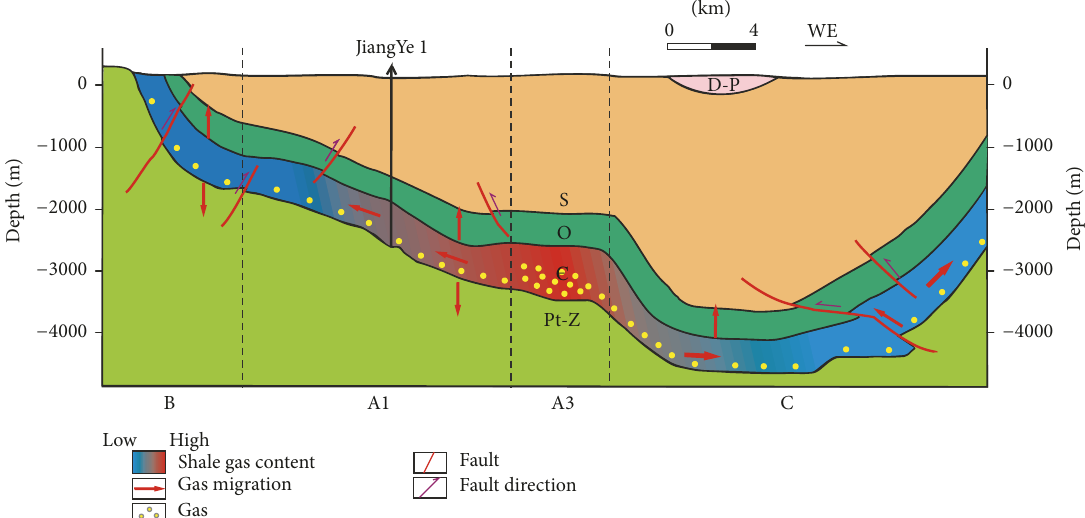
Figure 11: Evaluation units and shale gas accumulation diagram of seismic line EW303.4, Xiuwu Basin. See Figure 10 for the seismic line location.